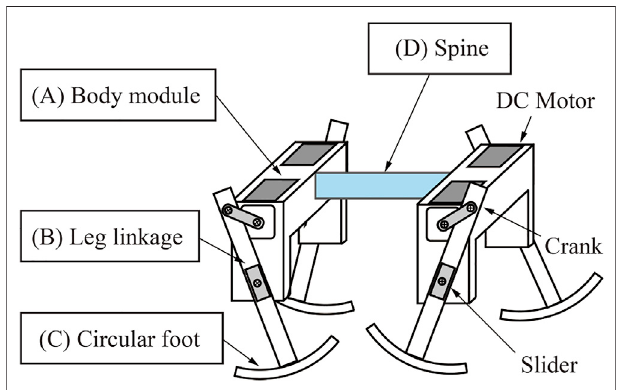
Frontiers in Robotics and AI |